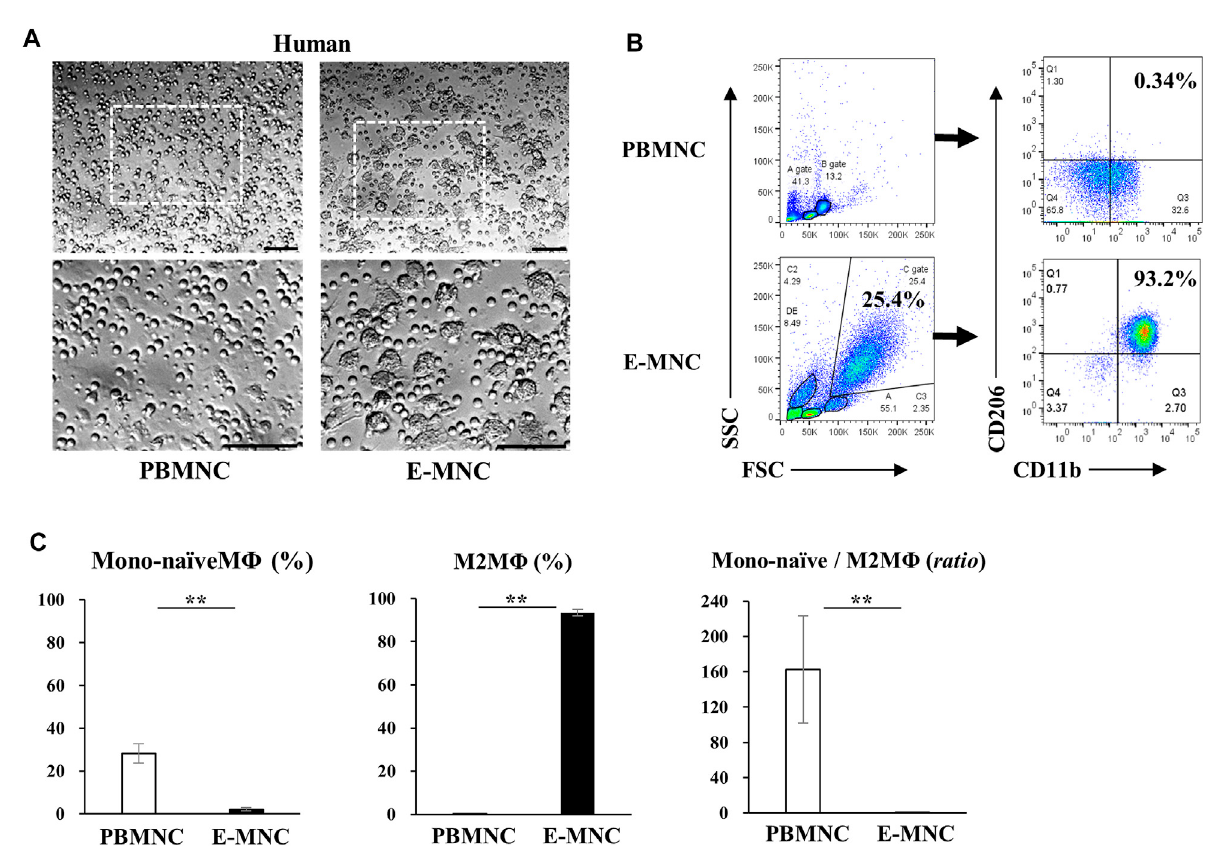
FIGURE 2 Characteristics of human E-MNCs. (A) Phase-contrast imaging of human PBMNCs (at day 0) and E-MNCs (at day 6). White boxed areas in the upper images (scale bar, 100 µm)weremagni fi edin thelower images (scalebar, 100 µm). (B) Flow cytometric analysis of FSC/SSC gated cells, CD11b + /CD206 − [Monocytes and/or naïve (Mono-naïve) macrophages] and CD11b + /CD206 + (M2) macrophages, among PBMNCs (at day 0) and E-MNCs (at day 6). (C) Percentages of Mono-naïve (CD11b + /CD206 − ) and M2 (CD11b + /CD206 + ) macrophage fractions and their ratios (Mono-naïve/M2) among PBMNCs and E-MNCs (** p < 0.01). For statistical analysis, the Student ’ s t-test was performed to determine the signi fi cance of differences among PBMNCs and